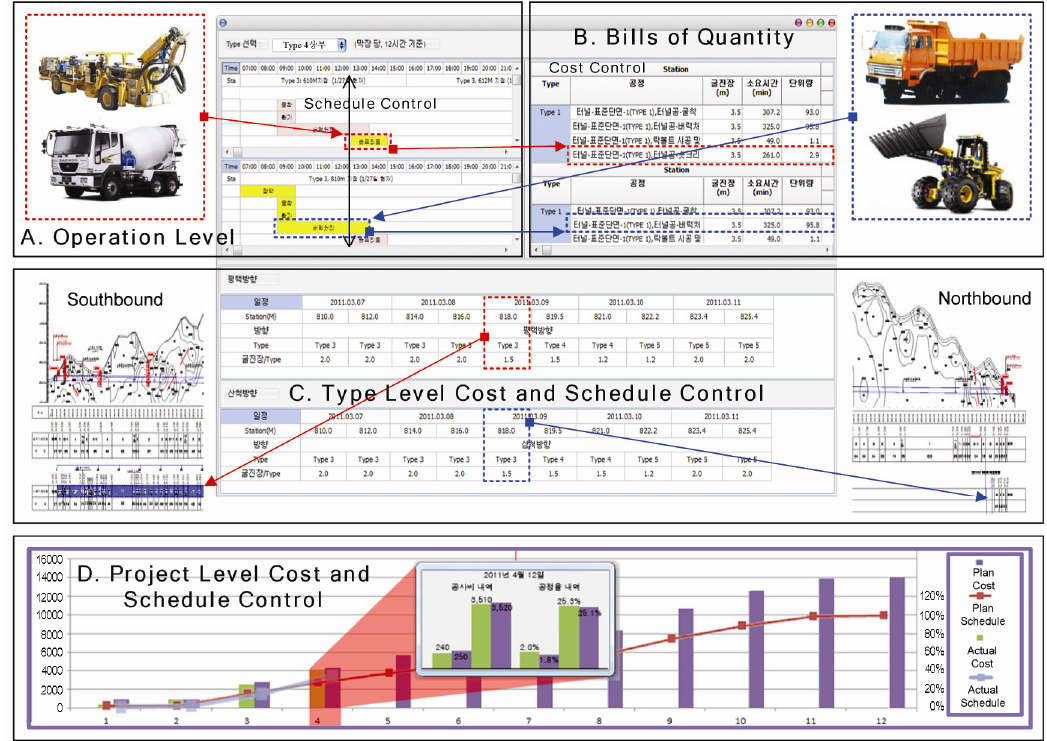
Fig. 5. A prototype model of the ADPS for integrated cost and schedule control